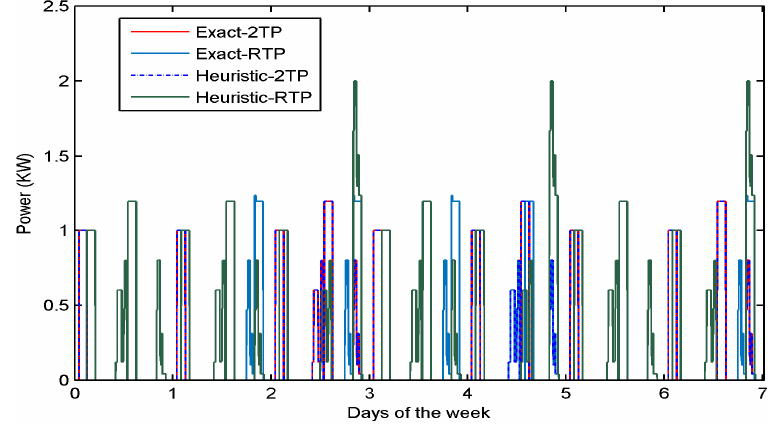
Figure 8. Power distribution across the first week of January 2014, representing winter period.